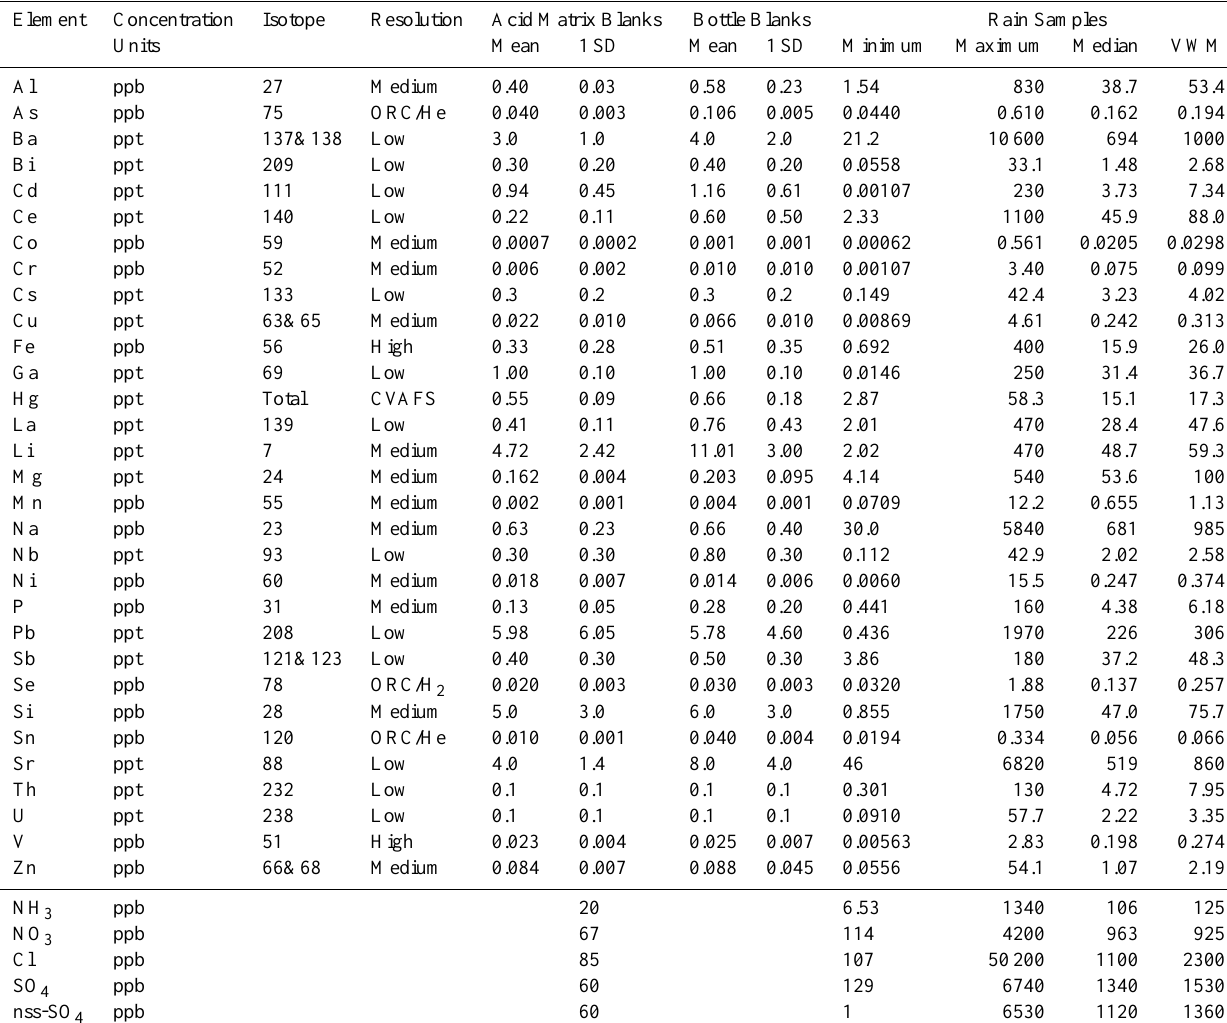
Table 1. Analytical information and descriptive statistics. See text for description of each column. VWM = volume weighted mean concentration for the three year period